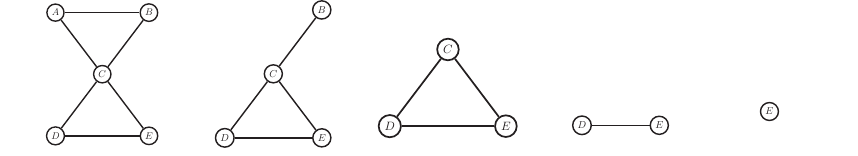
Figure 6. Finding the treewidth of a five vertices graph by eliminating vertices with the vertex elimination order π opt = ( A , B , C , D , E )